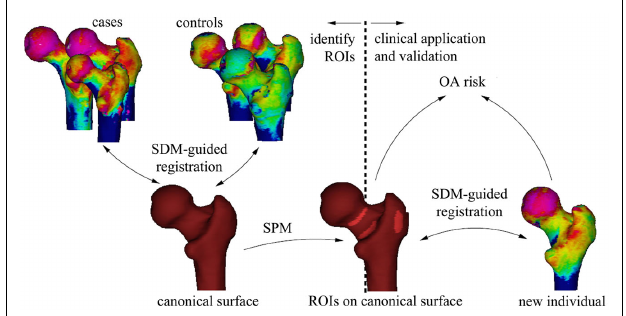
FIGURE 9 |The process of using SPM to establish ROIs that represent significant sites of cortical thinning that through clinical application and validation could be used to assess for the risk of osteoarthritis in a new individual. Image courtesy of Dr. GrahamTreece, Department of Engineering, University of Cambridge.